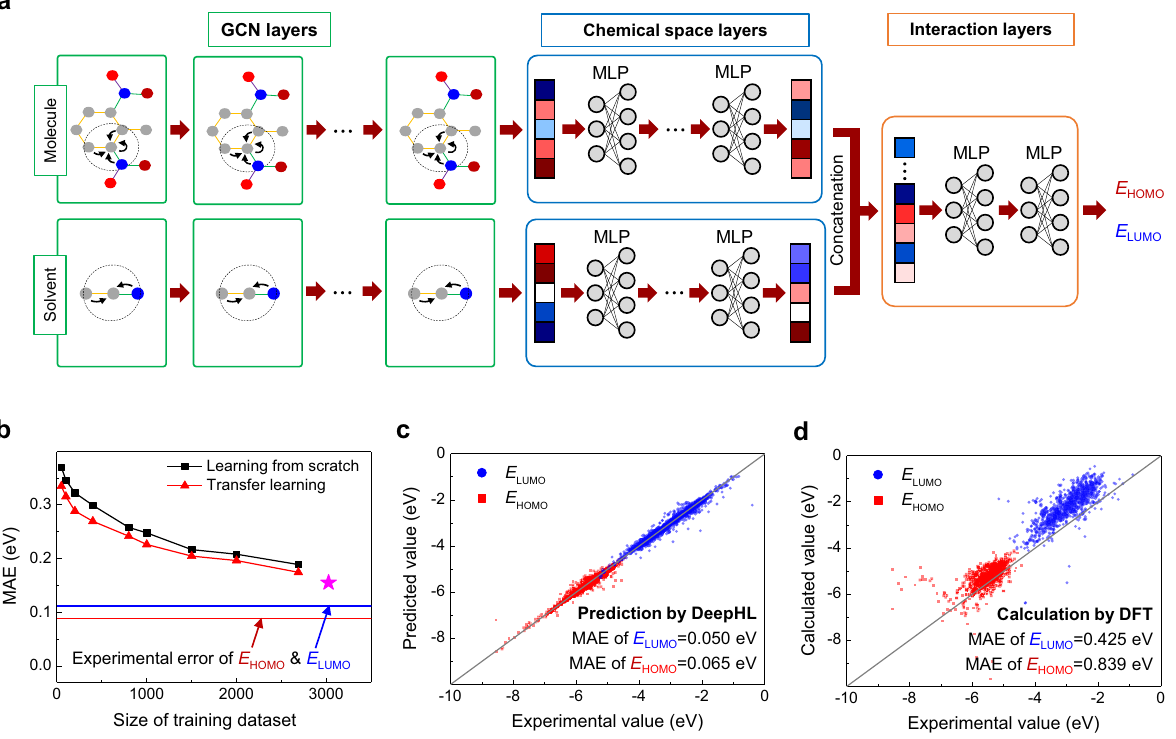
Fig. 2 Deep learning model. a Schematic illustration of our DL model used to predict the HOMO and LUMO energies ( E HOMO and E LUMO ) of 2,6-dinitrotoluene in acetonitrile. See the Methods for the detailed architecture of our DL model. b The mean absolute errors (MAEs) in the test dataset as a function of the training dataset size. The MAE of our DeepHL model is indicated by a magenta star. The solid lines represent the experimental errors of HOMO (red) and LUMO (blue) energies, respectively. c HOMO and LUMO energies of all molecules in our database predicted by our DL model (DeepHL). d HOMO and LUMO energies of 988 organic molecules, calculated using DFT methods (B3LYP/6-31